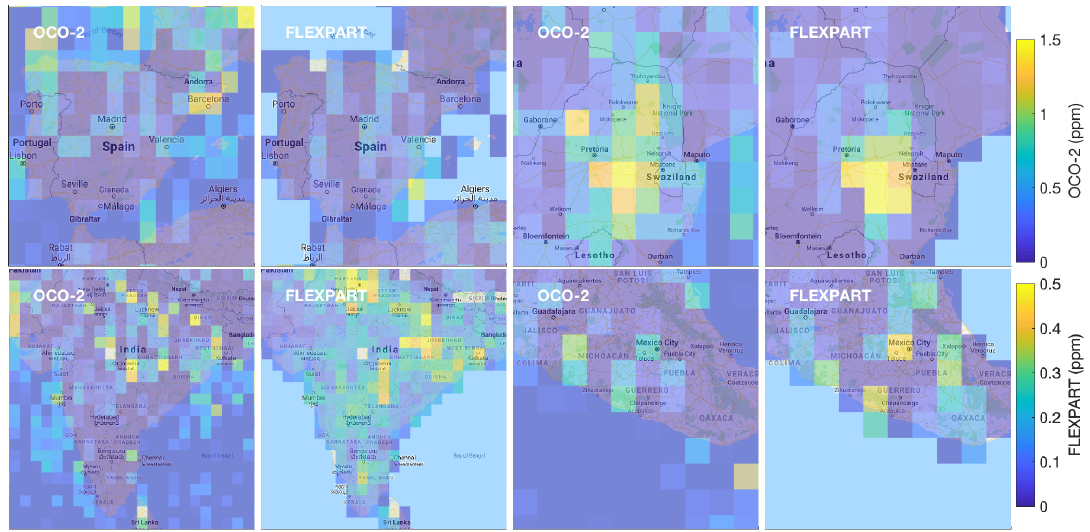
Figure 9. Case studies for the year 2015: Iberian peninsula, Highveld industrial region in South Africa, India, and Central America. OCO-2 XCO 2 anomalies and FLEXPART XCO 2 enhancements are overlapped to the Google map